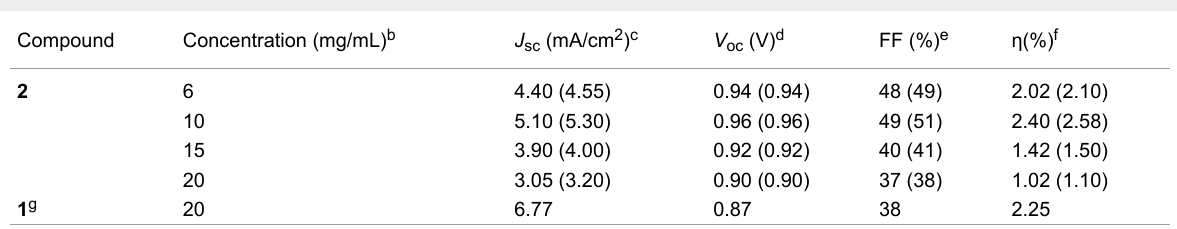
Table 3: OPV device performance.